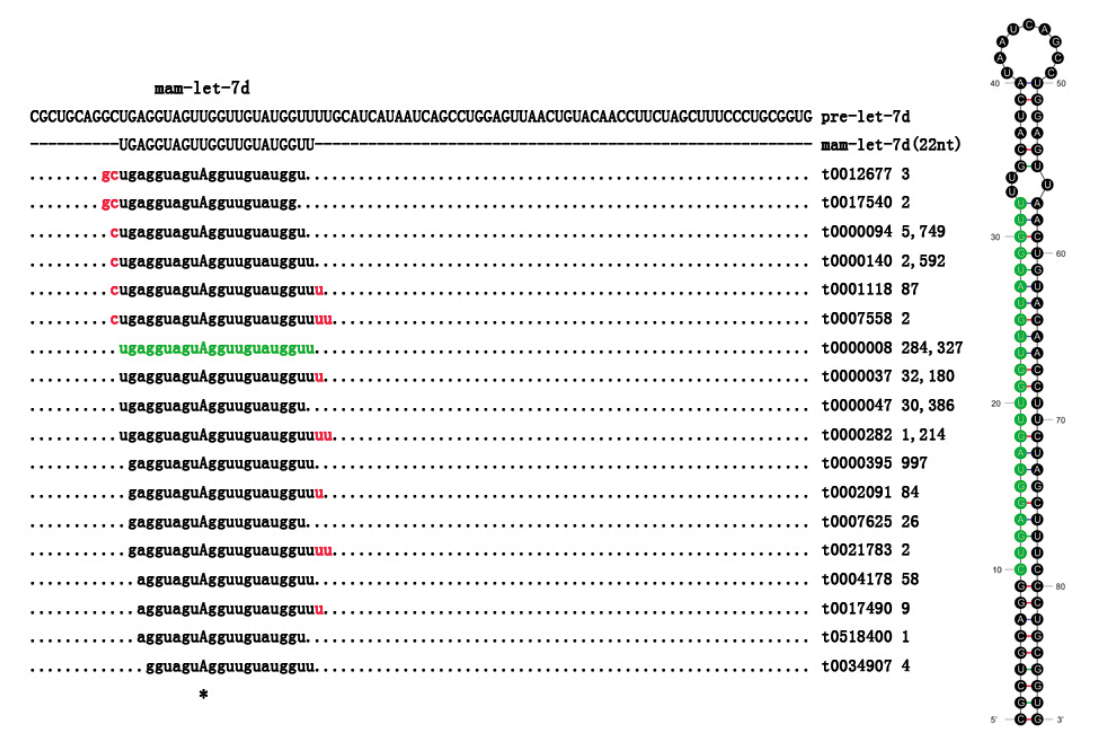
Figure 4. A portion of the miRNA precursor and details of mam-let-7d isomiRs, including sequence count. The most abundant mature miRNAs are indicated by the sequence in green. The non-templated nucleotide additions were indicated in the red. * indicated the single nucleotide mutation